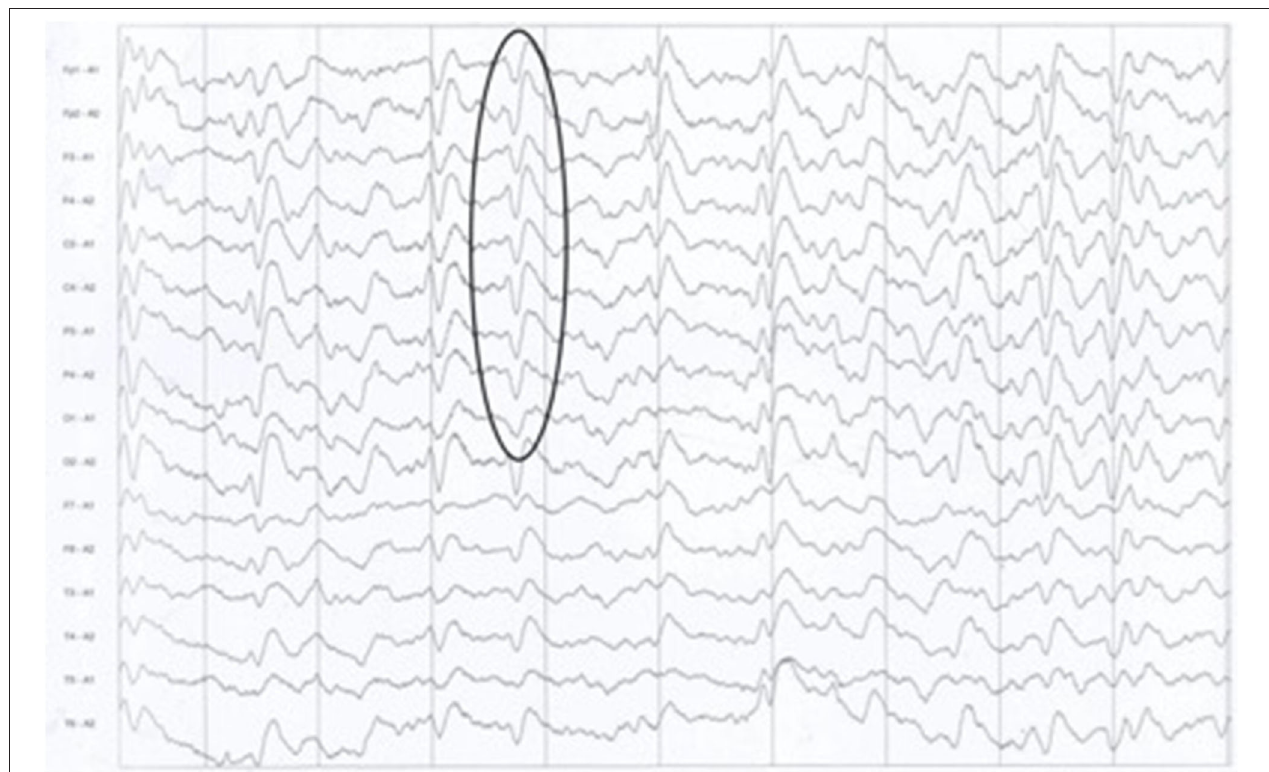
FIGURE 2 | The typical presence of periodic sharp wave complexes (PSWCs) on the electrocephalogram of patient 1.